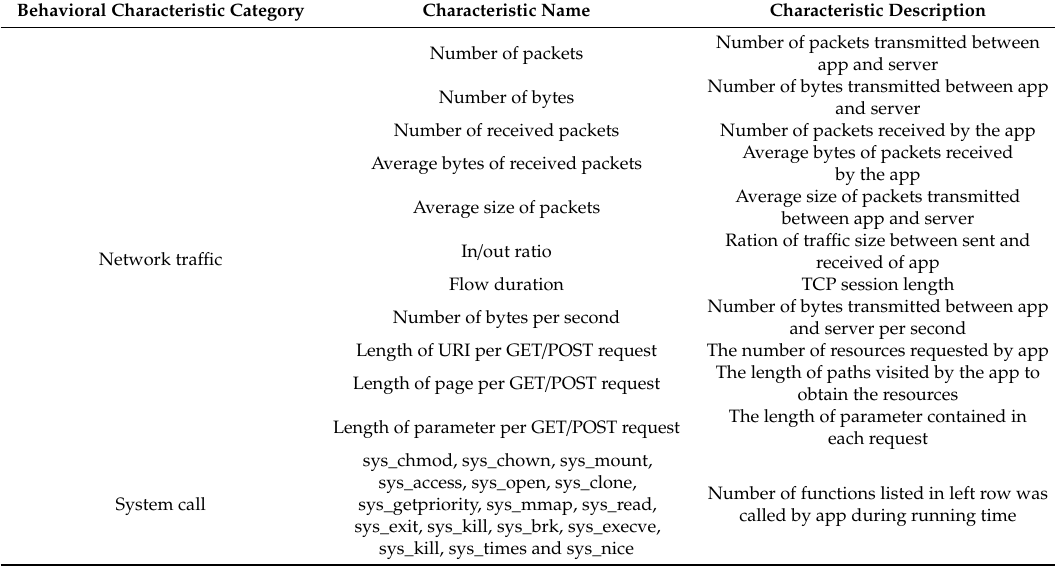
Table 2. Detail information about selected dynamic behavioral